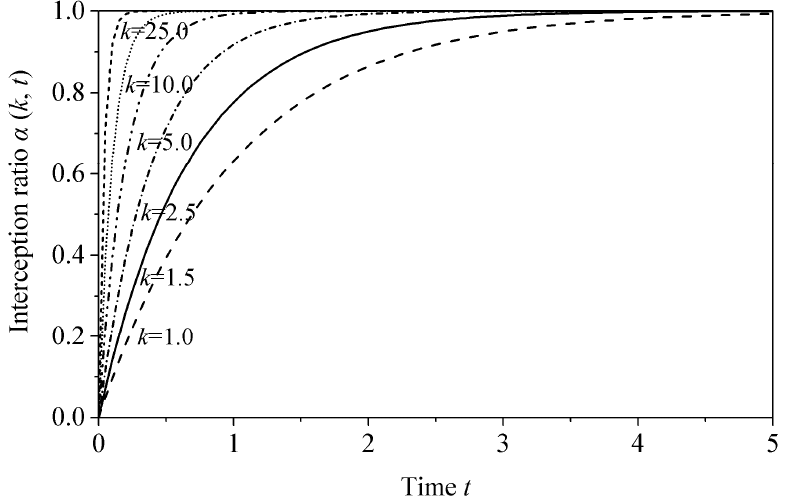
Figure 1. Dynamics of interception ratios with different exponential coefficients. k is the exponential coefficient; α is the interception ratio; t is the time duration of interception.